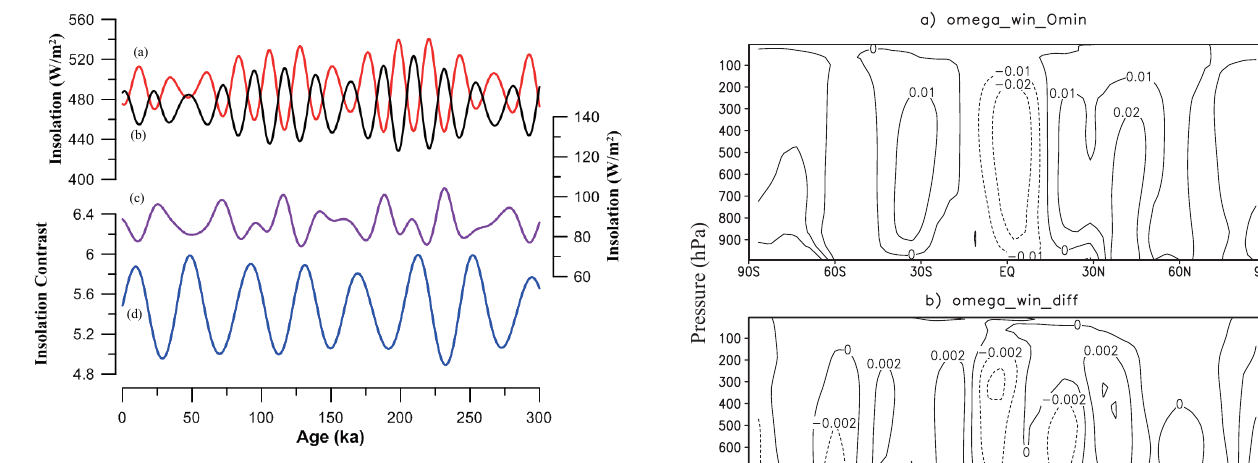
Fig. 8. Orbital insolation: (a) 30 ◦ N June insolation (red); (b) 20 ◦ S December insolation (black); (c) 50 ◦ N December insolation (pur- ple); (d) ratio between (b) and (c) (blue). The insolation values are calculated by Berger (1978).